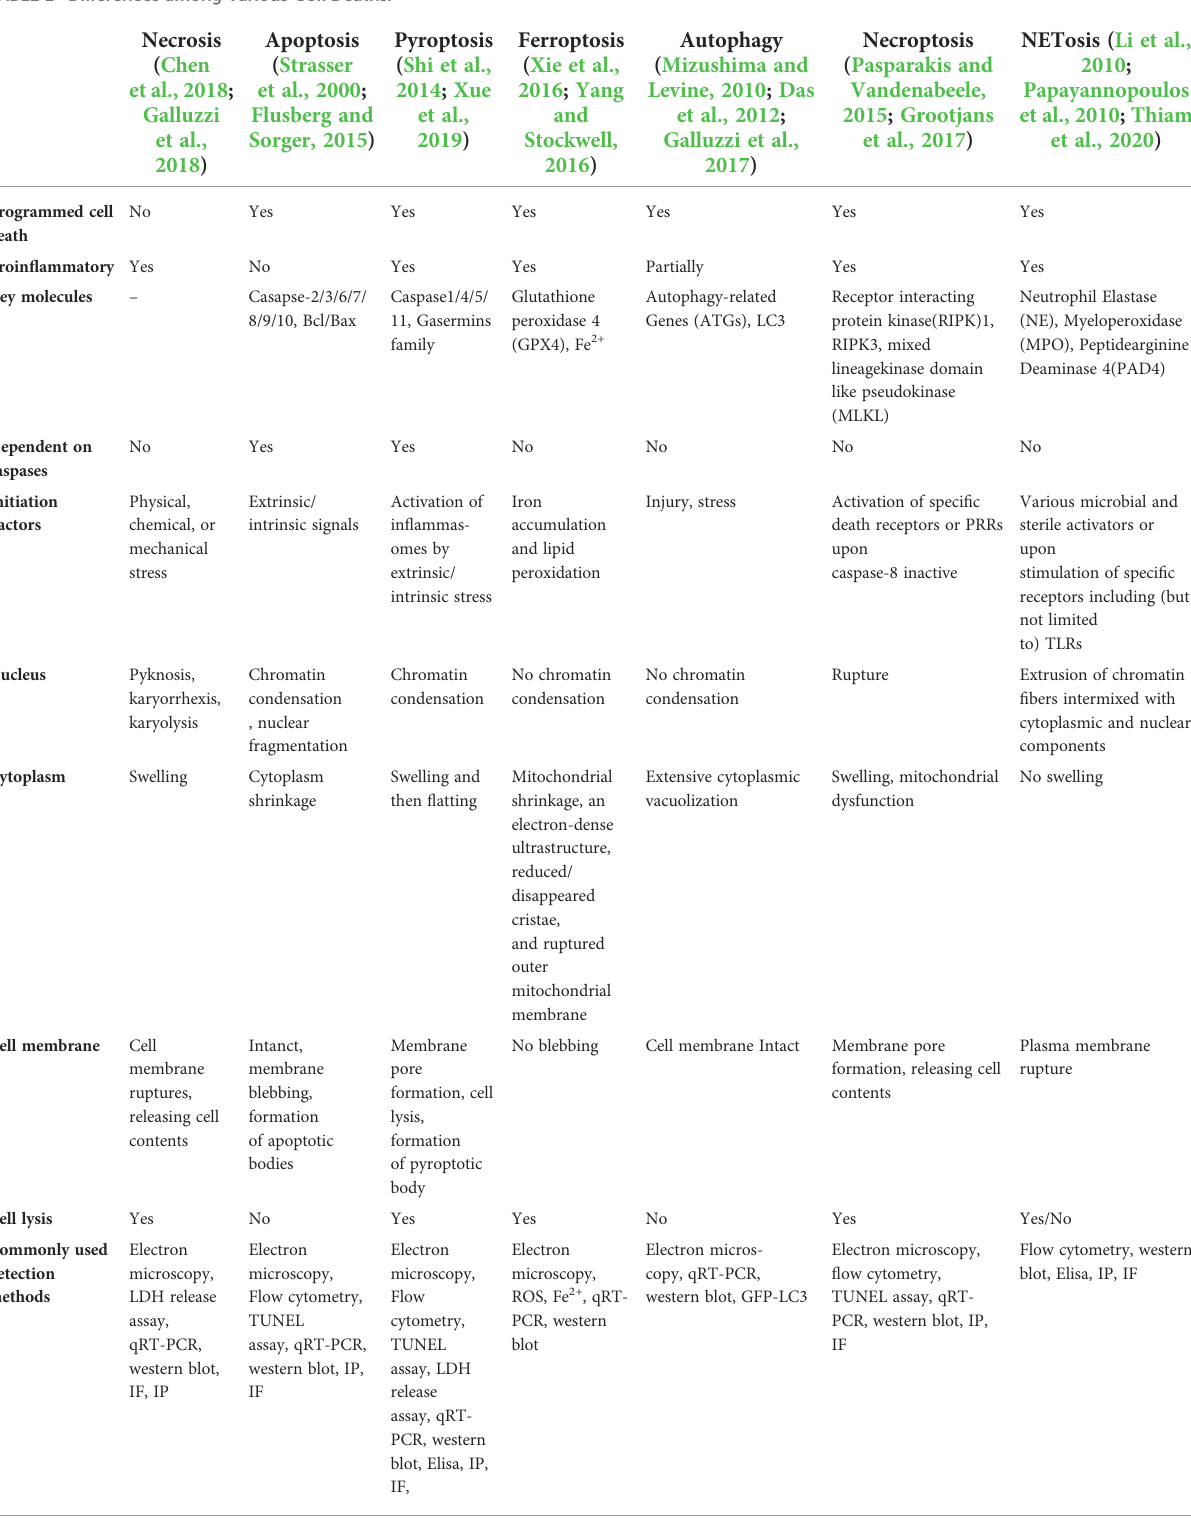
TABLE 1 Differences among Various Cell